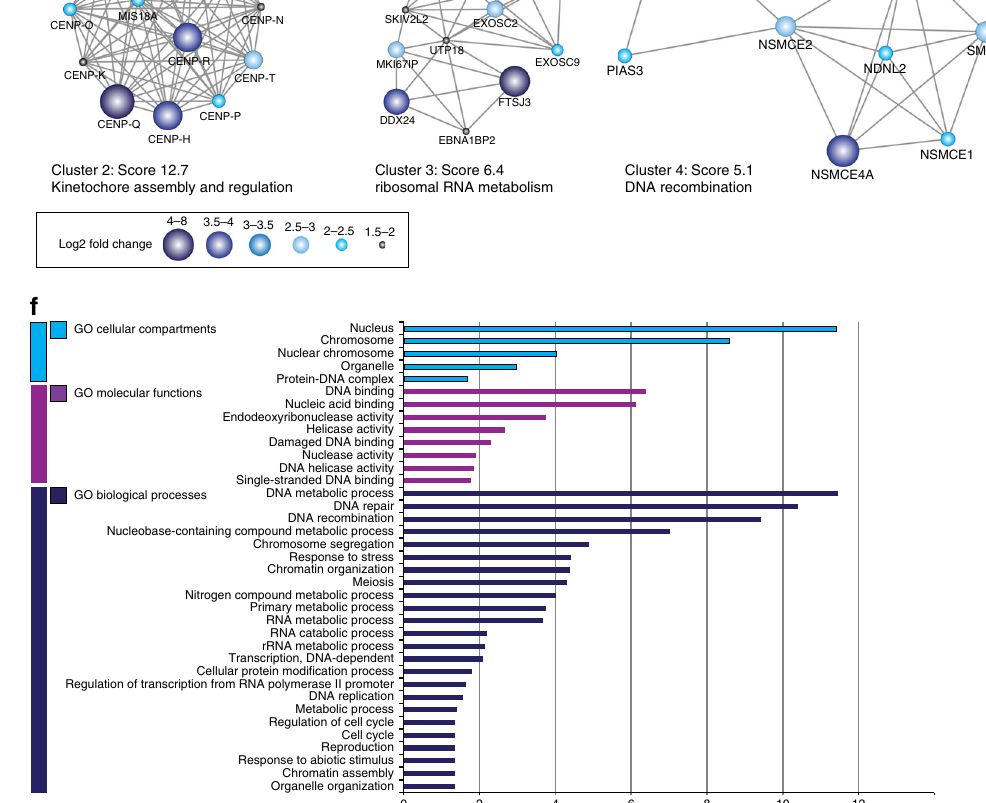
Fig. 3 SENP6 demonstrates group deSUMOylation activity. a STRING network analysis of enriched proteins after SENP6 knockdown, with a STRING interaction con fi dence of 0.7 or higher. Cytoscape software was used to visualize the interaction network. Color and node size indicate the fold-change differences in abundance after SENP6 knockdown compared with the nontargeting control. b MCODE was used to extract the most highly interconnected clusters form the network shown in a . Cluster 1 contains multiple proteins involved in DNA damage response. c Cluster 2 includes multiple kinetochore and kinetochore-associated proteins. d Cluster 3 includes proteins that are involved in ribosomal RNA metabolism. e Cluster 4 contains proteins associated with DNA recombination and the SUMOylation pathway. f Gene Ontology (GO) enrichment analysis of SENP6-regulated proteins. The bar graph shows the most signi fi cantly overrepresented GO terms for biological processes (BP) in dark blue, molecular functions (MF) in purple, and cellular compartments (CC) in light blue compared against the annotated human proteome. Source data are provided as a Source Data fi